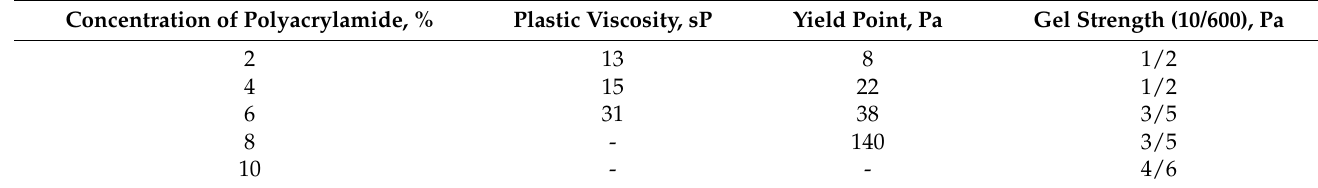
Table 2. Rheological characteristics of aqueous solution of polyacrylamide.